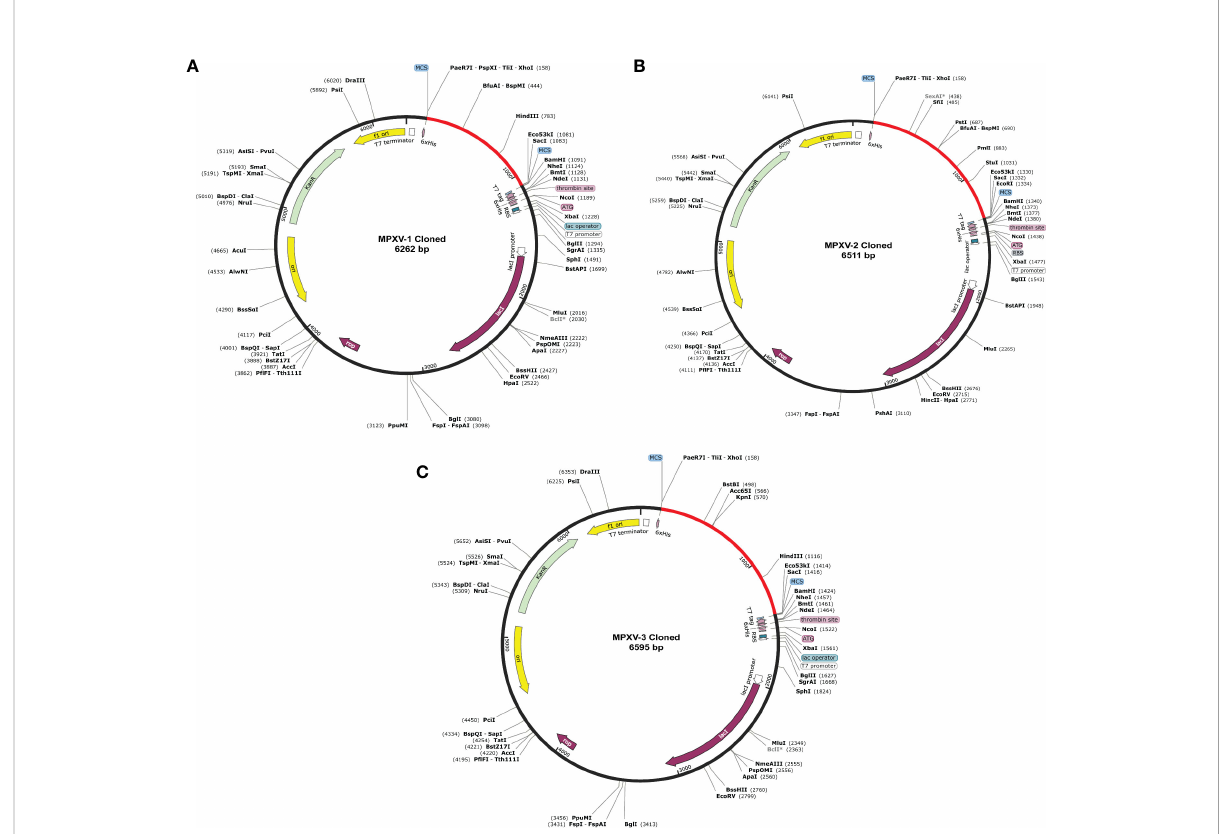
FIGURE 8 In silico cloning of the designed vaccine constructs (A) MPXV-1 (B) MPXV-2 (C) MPXV-3. The optimized DNA sequence of the proposed vaccine construct(s) (shown in red) was cloned between the XhoI and SacI enzyme loci in the expression vector pET-28a (+) (shown in